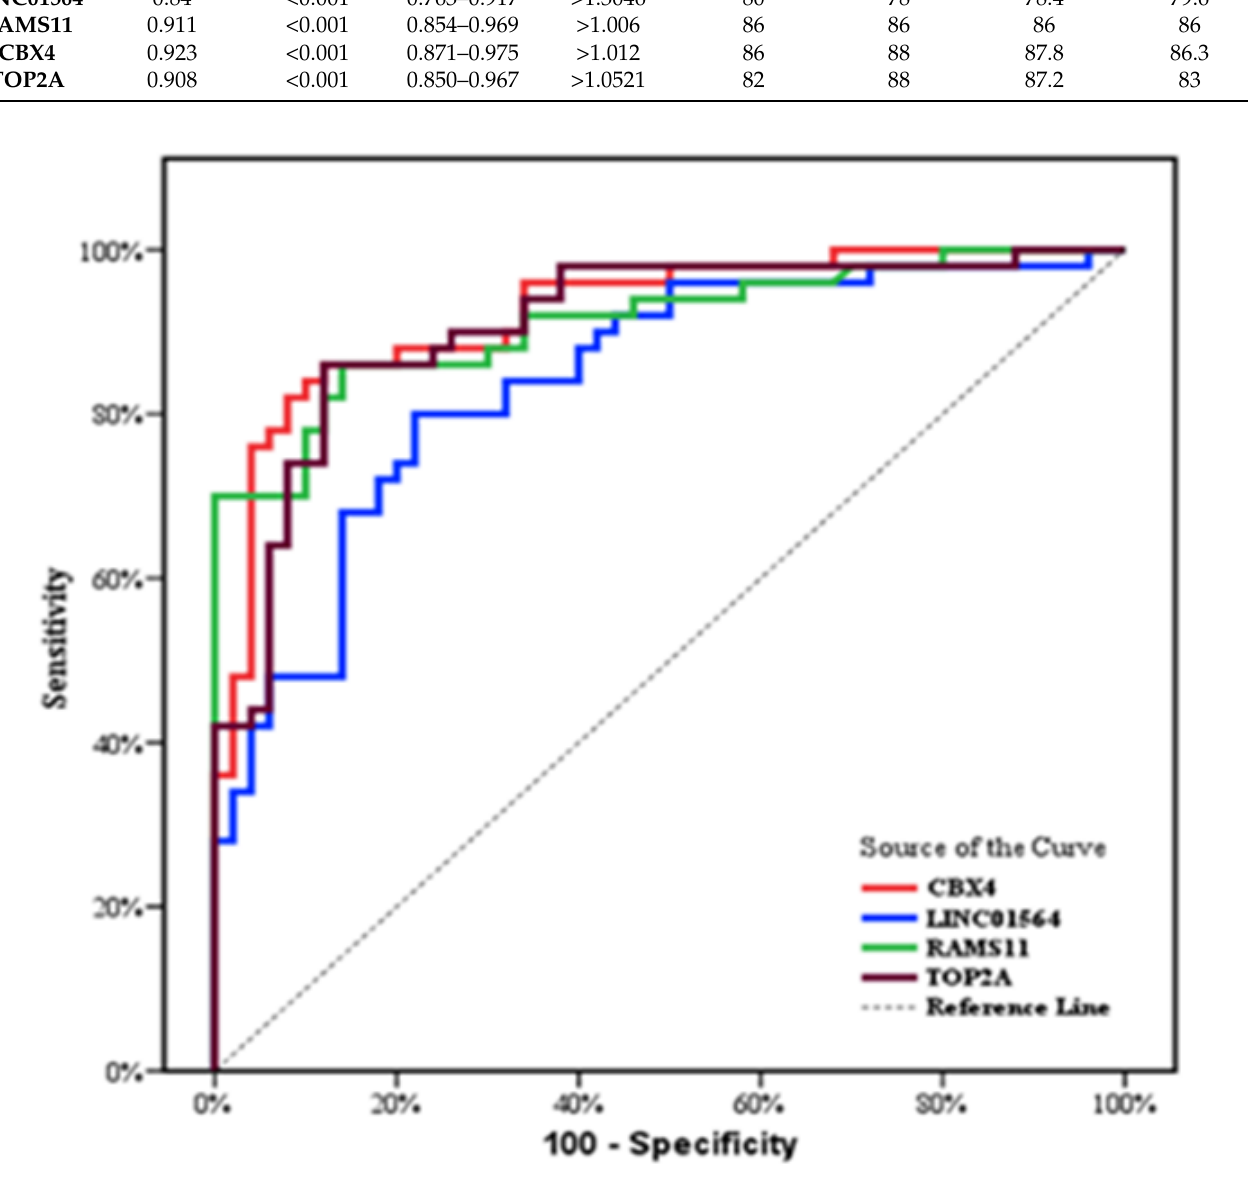
Figure 3. ROC curve for different parameters to discriminate HCC group form HCV group. 3.3. Regarding Correlations between the Relative Expression Level of lncRNA with Clinical and Biochemical Parameters among Case Group Showed That The relative expression level of lncRNA (CBX4, LINC01564, RAMS11 and TOP2A) showed a positive correlation in HCC group with ALT, AST and overall survival time, on the other hand were insignificantly correlated with age, Hb, platelets, WBCS, serum albumin, total bilirubin, direct bilirubin, PT and α FP (Table